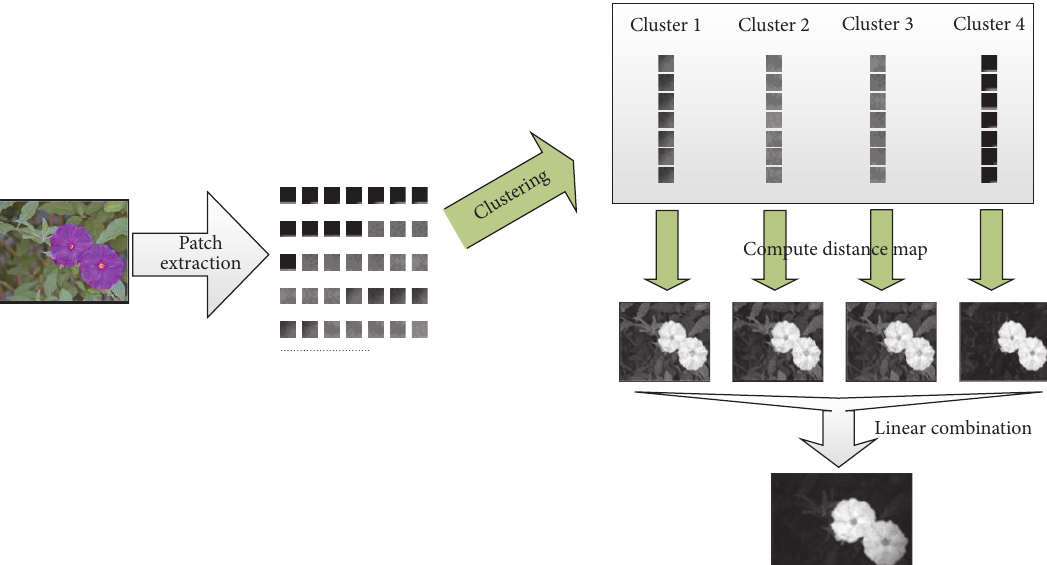
Figure 2: Coarse saliency map generation